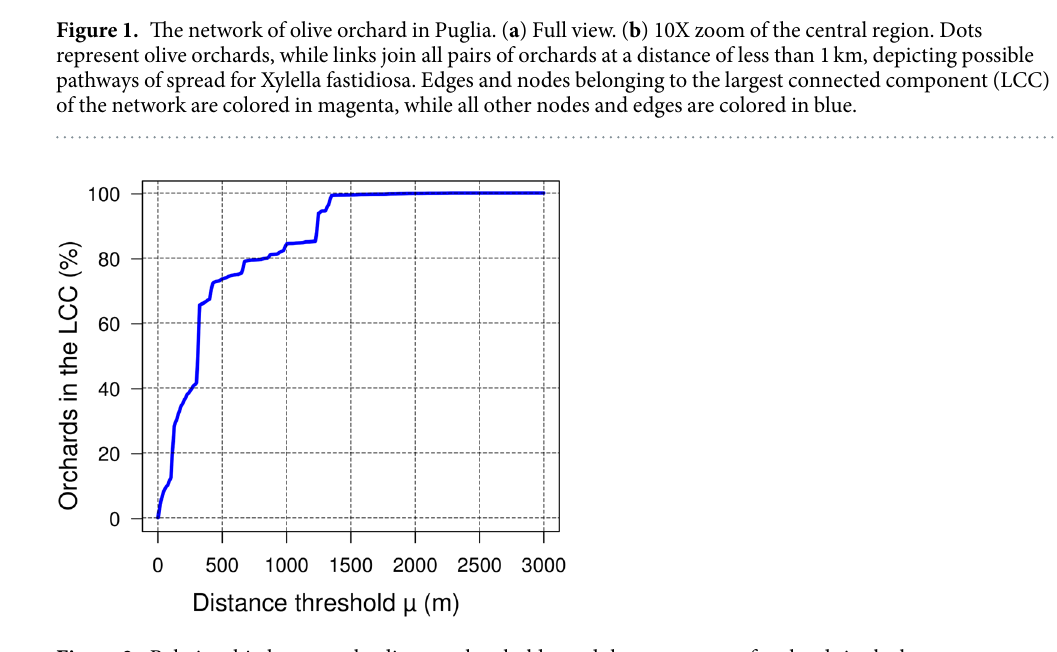
Figure 2. Relationship between the distance threshold μ and the percentage of orchards in the largest connected component (LCC) of the corresponding network. When μ exceeds 1,500 m more than 99.9% of the orchards belong to the LCC and the entire network is almost